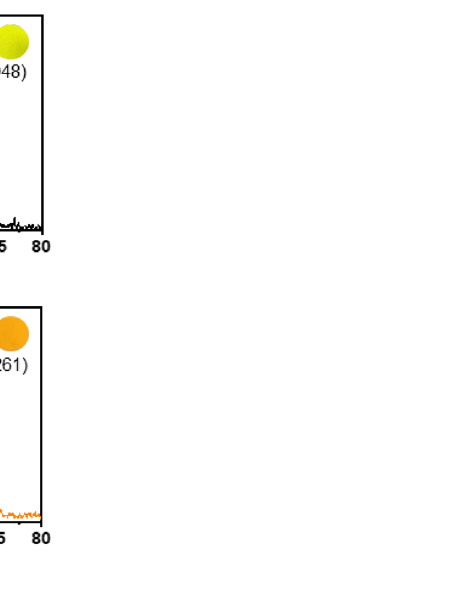
Figure 7. XRD patterns of fabricated yellow ( a ) and amber ( b )